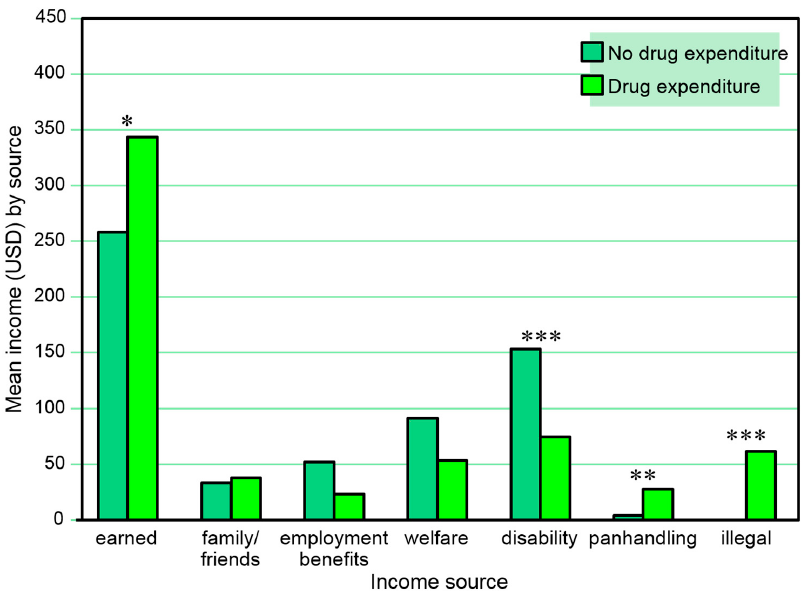
Figure 7. Total amounts earned from various 30-day income sources among those with and without 30-day drug expenditures across three interviews. * p ≤ 0.05, ** p ≤ 0.01, *** p ≤ 0.001. Table 8. Amounts earned from various 30-day income sources among those with and without 30-day drug expenditures in the same